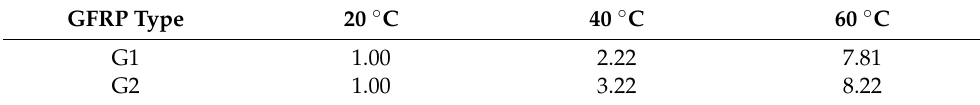
Table 18. TSF at temperatures of 20, 40, and 60 ◦ C based on the fourth prediction model.